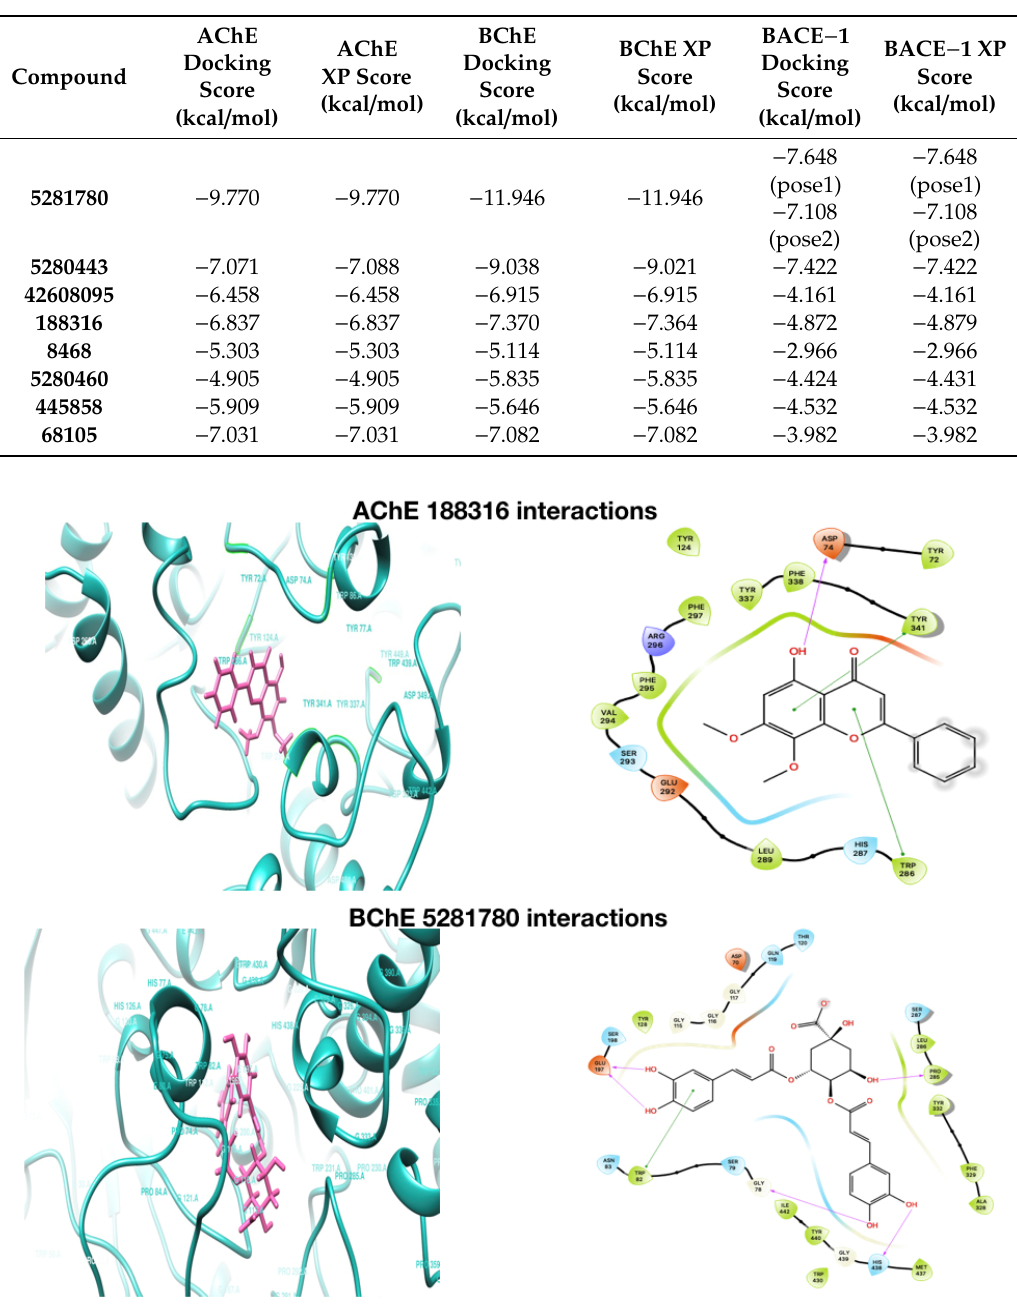
Table 1. Docking score and XP score of the selected compounds with AChE, BChE, and BACE-1 obtained from Schrodinger software. AChE: acetylcholinesterase, BChE: butyrylcholinesterase,